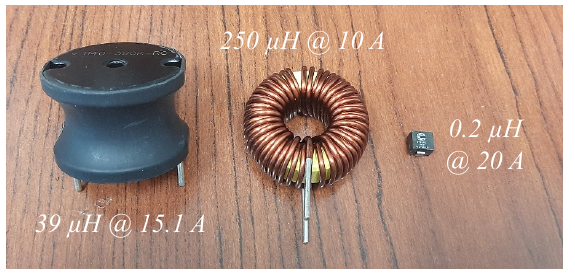
Figure 18. Comparison between two energy storage inductors and a tiny resonant inductor.